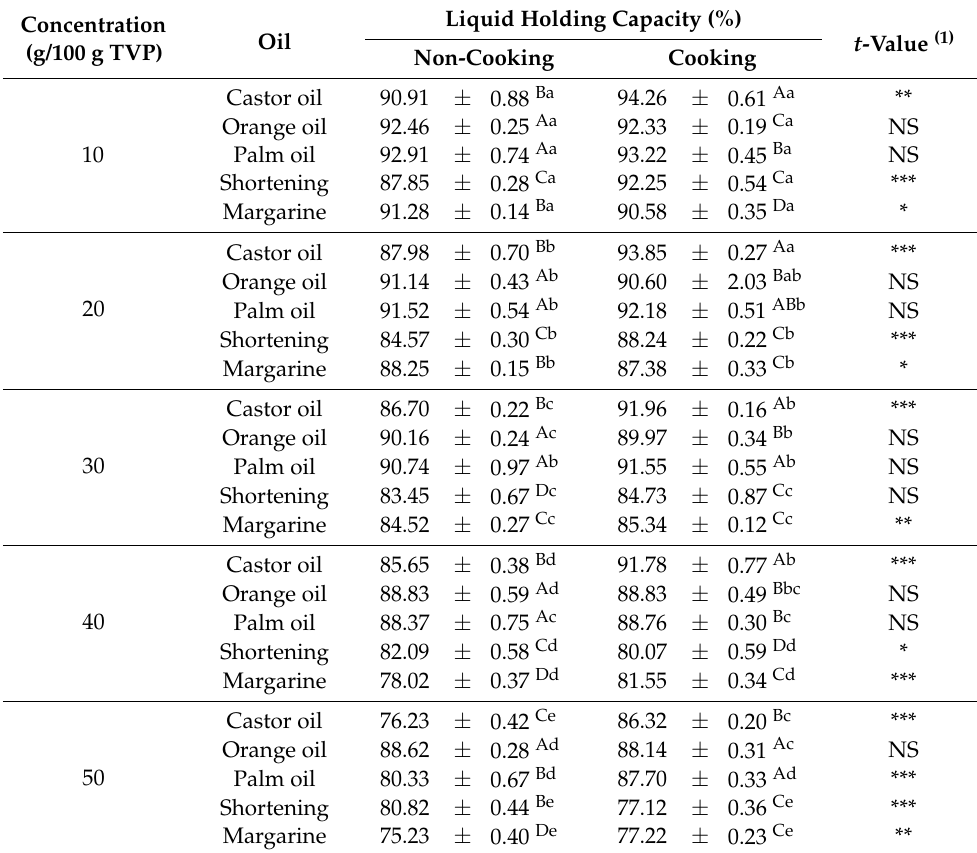
Table 6. Liquid holding capacity (%) of meat analog supplemented with different types or amounts of vegetable oils stored at 35 ◦ C